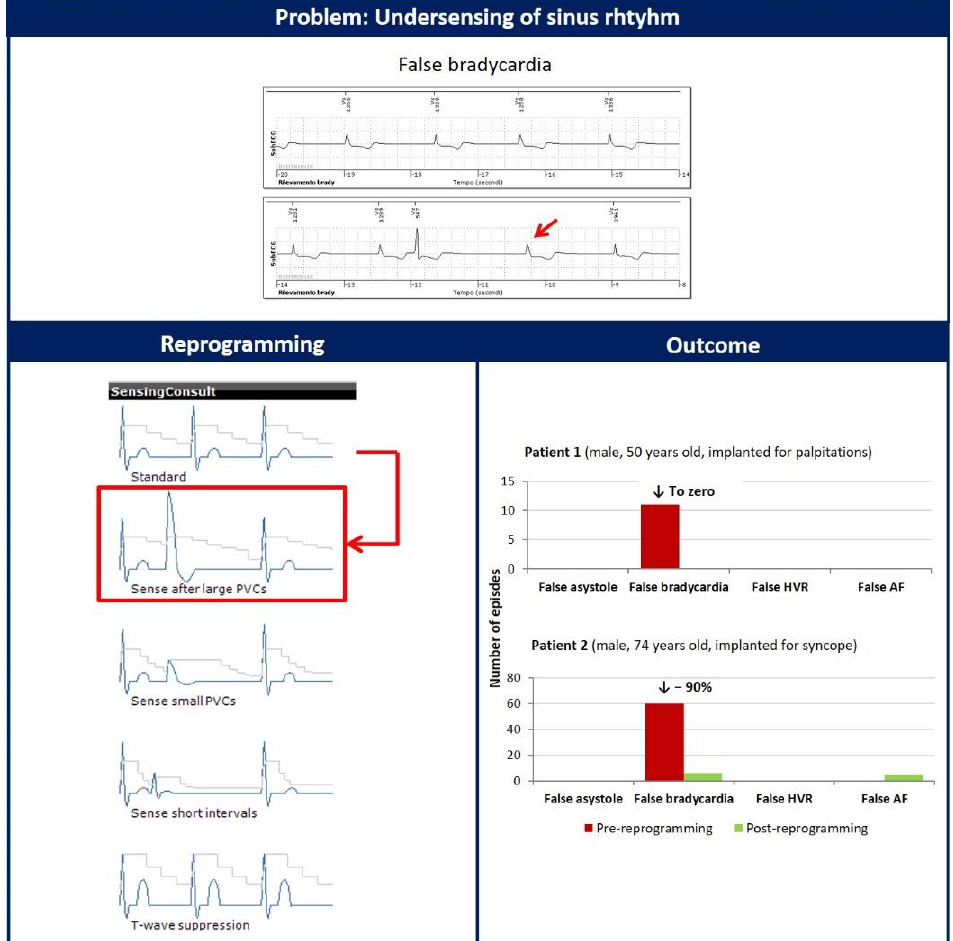
Figure 2. The red arrow indicates the undersensing of one sinus rhythm R wave following a high- amplitude PVC. Reprogramming of the parameter ‘ Sensing Consult ’ from ‘ Standard ’ to ‘ Sense after large PVC ’ dramatically decreased the number of false bradycardia episodes.